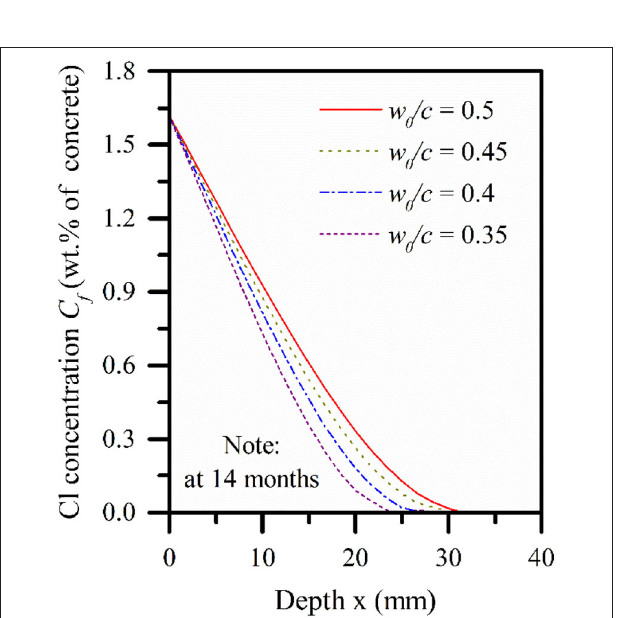
sulfate ion concentration in pore solution. Shaheen and Pradhan (2015), respectively studied the determination of free chloride ion content in the mixed solution with the same chloride ion concentration by 3, 6, and 12% sulfate ion. The results showed that the free chloride ion concentration decreased with the increase of sulfate ion concentration. In this study, the chemical binding model established by Hirao et al. (2005), see Equation (2- d) and based on Paul’s experimental data for quantitative